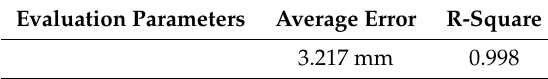
Table 4. The evaluation parameters of fitting